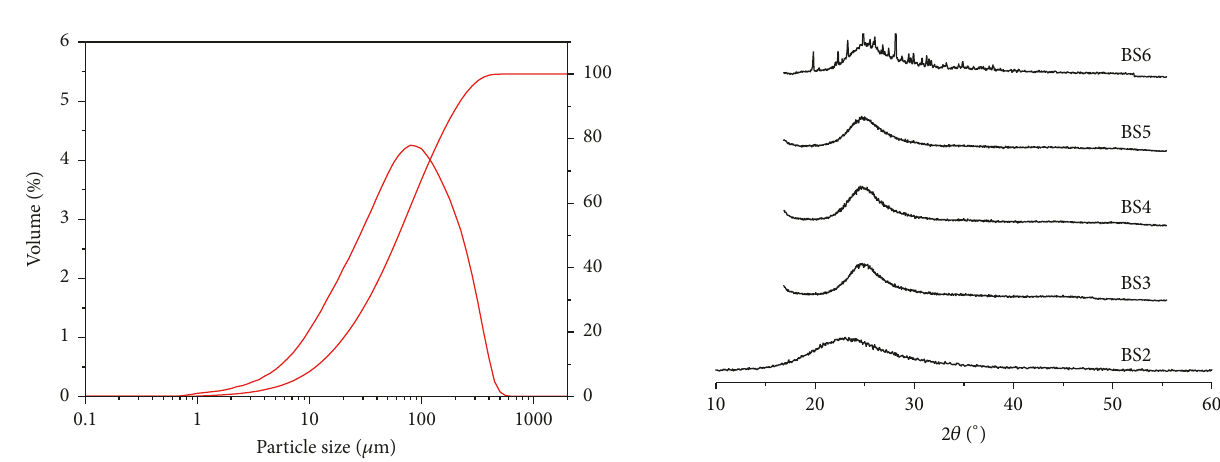
Figure 4: XRD patterns of the synthesis products obtained by hydrothermal treatment of sugarcane waste ash at 100 ∘ C.